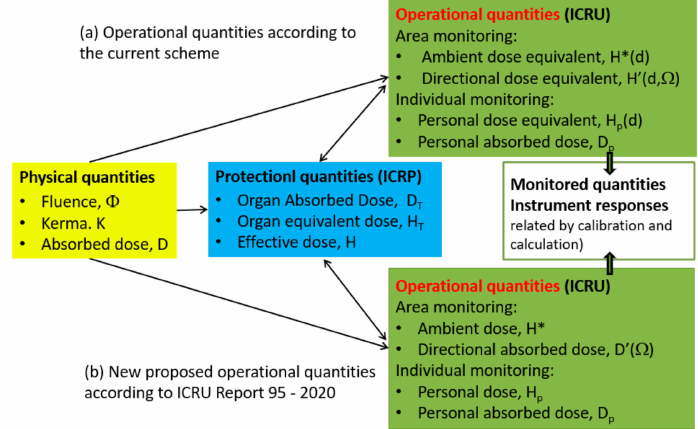
Figure 1. Relationship between the protection quantities of ICRP Publication 103 [5] and the op- erational ones of ICRU according to ( a ), the current scheme; ( b ) Report 95 [7], the new proposed operational